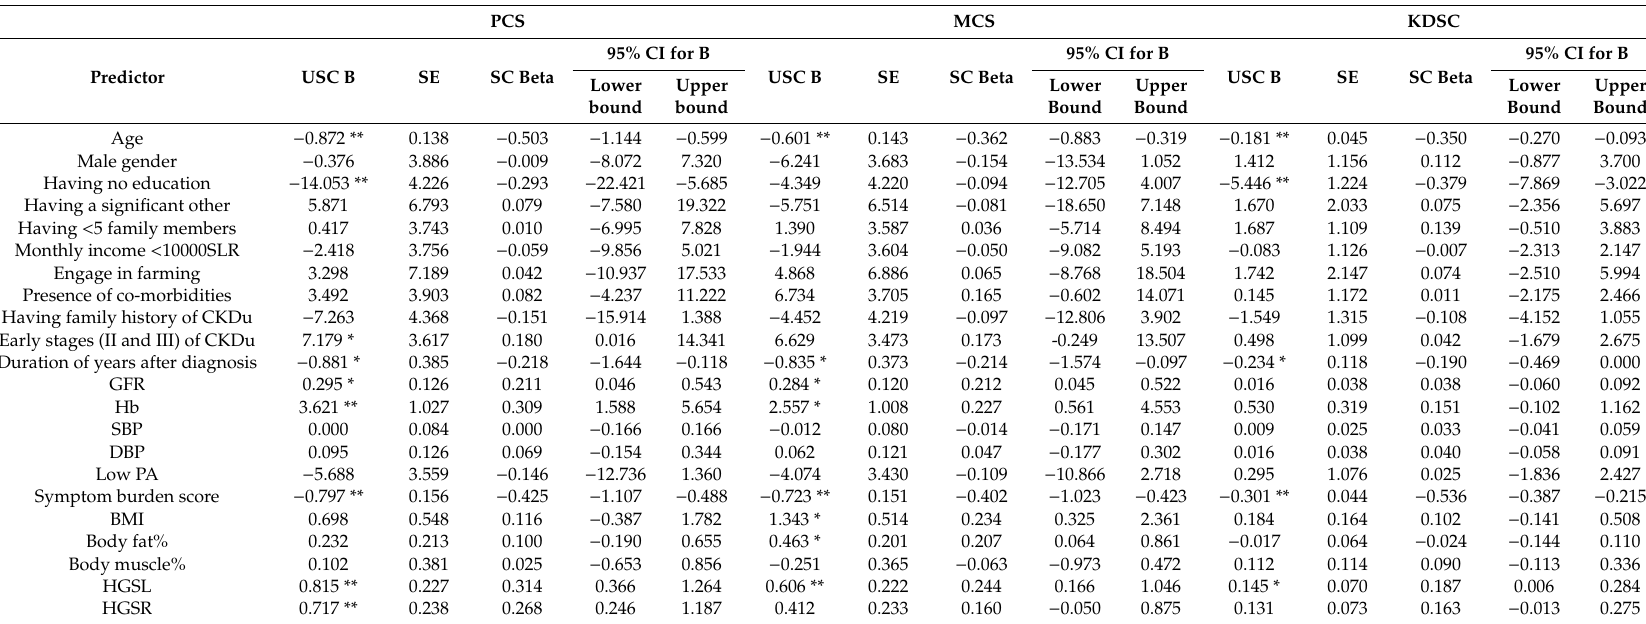
Table 5. Simple linear regression of socio-demographic, health-related, and anthropometric parameters with PCS, MCS, and KDSC